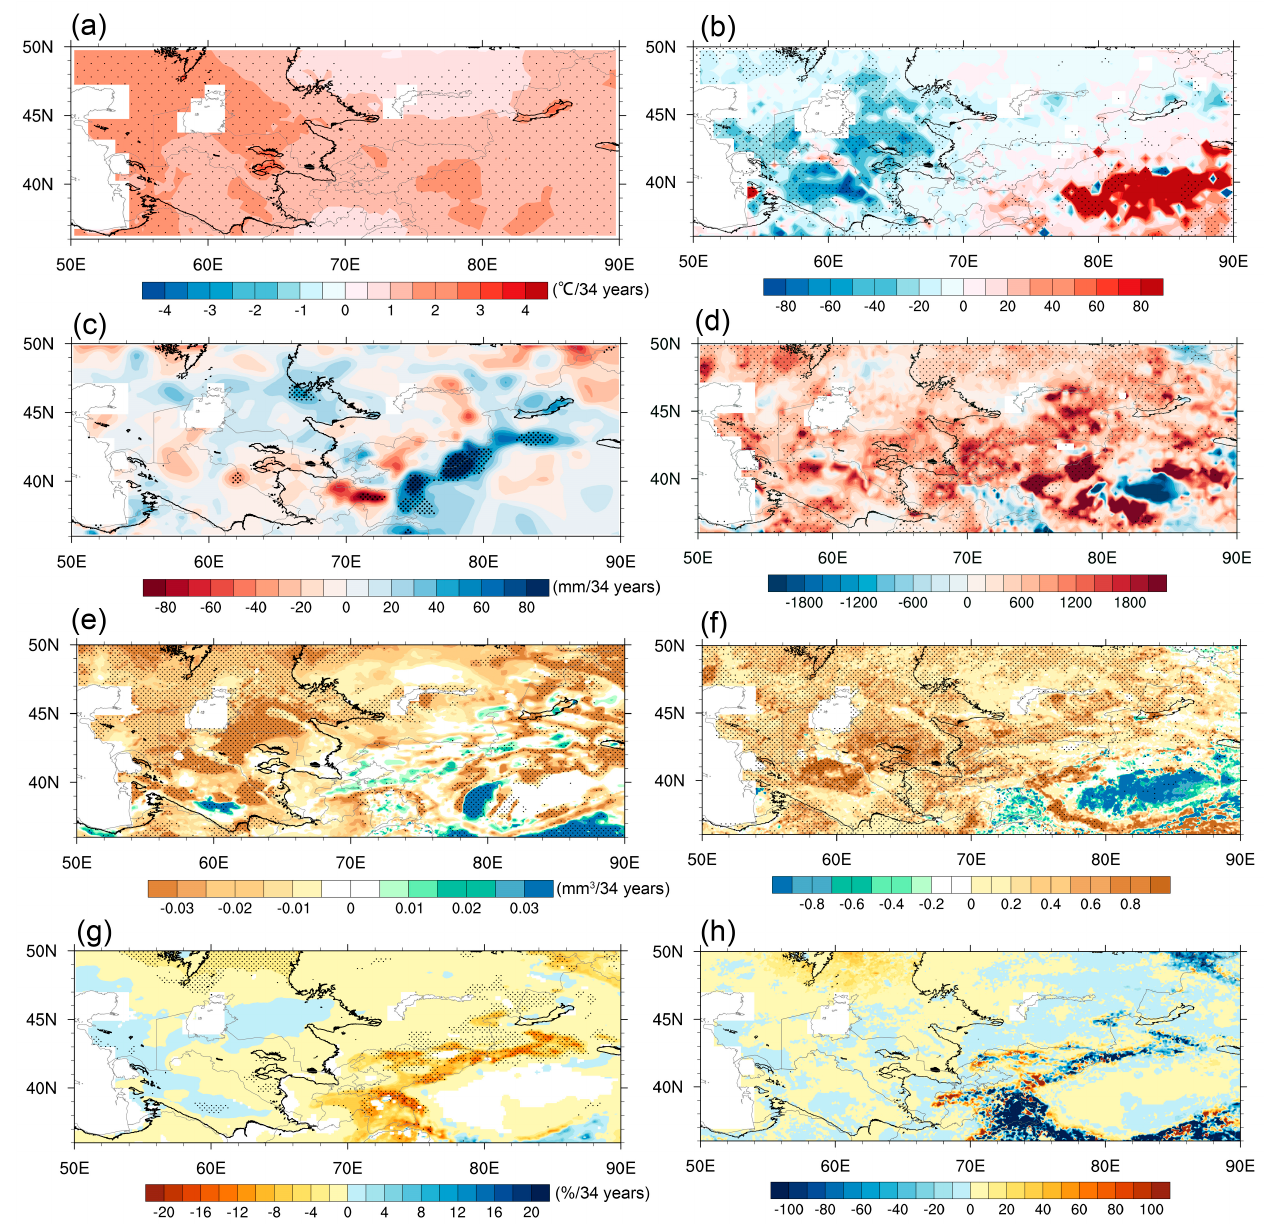
Figure 4. Distribution of trends in temperature ( a ), precipitation ( c ), soil water ( e ), and snow cover ( g ). Distribution of regression coefficients between temperature ( b ), precipitation ( d ), soil water ( f ), and snow cover ( h ) with NDVI. The black dots are areas that passed the significance test ( p < 0.05).